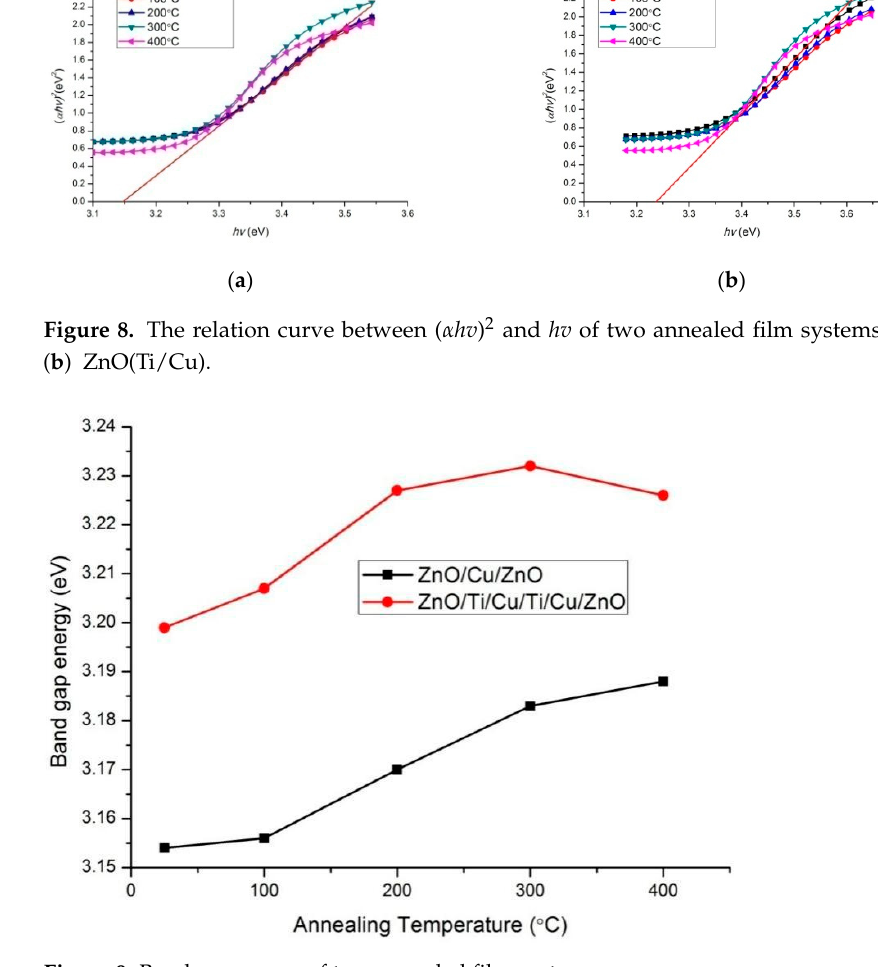
Figure 9. Bandgap energy of two annealed film systems.